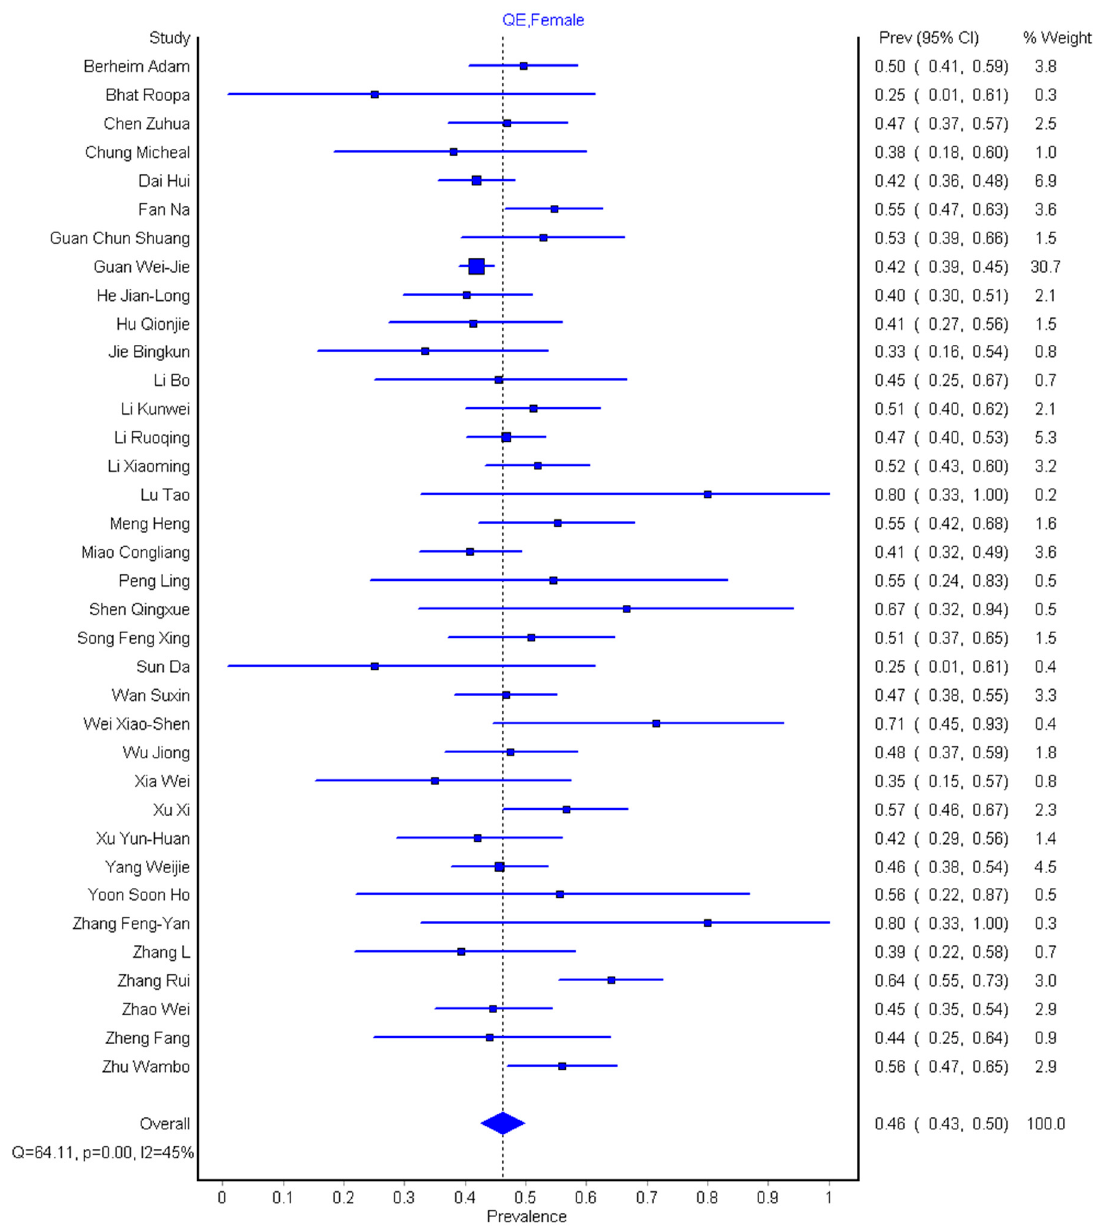
Figure A2. Forest plot of the pooled prevalence of female patients.